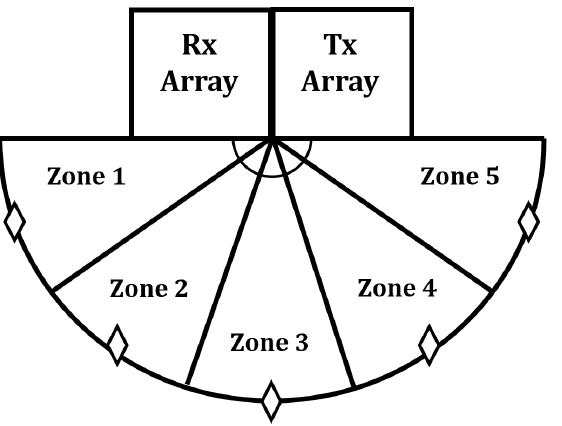
Figure 4. Top-down representation of BS and client zones. Not drawn to scale. Diamonds indicate approximate location of client